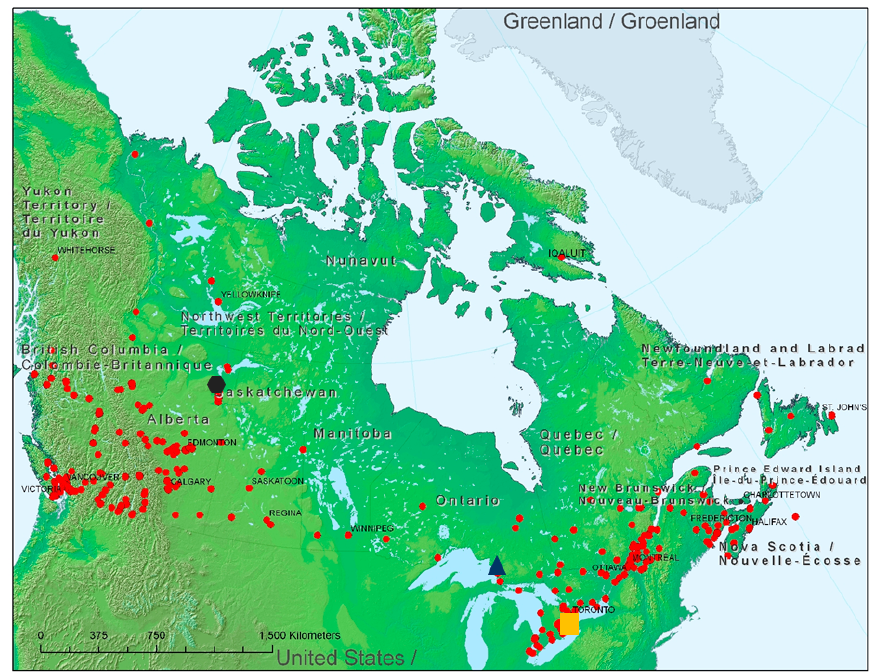
Figure 2. Locations of NAPS monitoring stations across Canada (adapted from ECCC [21]).